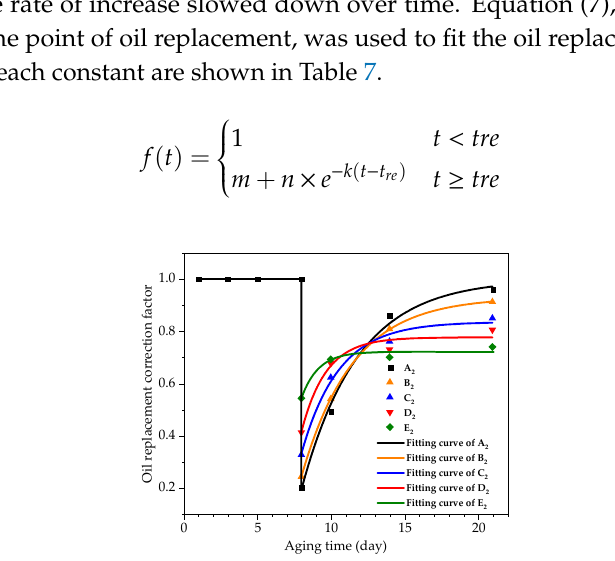
Figure 14. Comparison between the predicted value and measured value of furfural distribution ratio in oil.